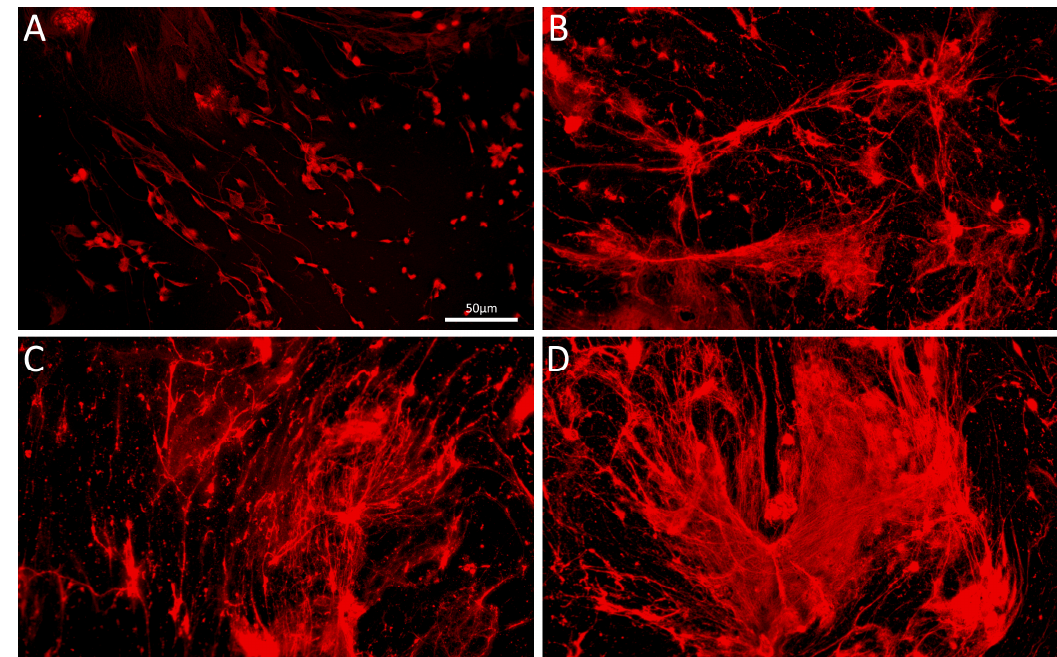
Figure 3. Gallbladder content, isolated from mice fed high-fructose diet for 4 weeks ( A , B ) and 6 weeks ( C , D ). DNA was stained with propidium iodide (red). Images A to D represent progressive stages of NETs formation endowed with a high tendency to aggregate; magnification is constant.